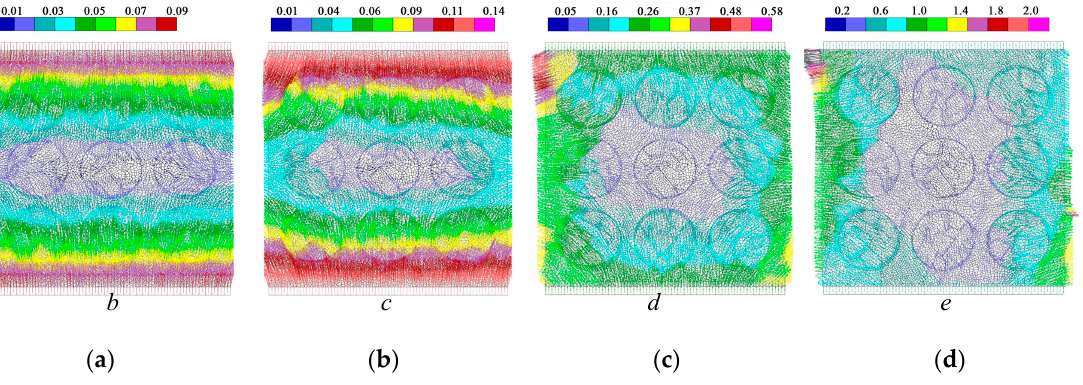
Figure 13. Displacement vectors of block corners from numerical simulation (unit: mm) ( a ) loading stage b ; ( b ) loading stage c ; ( c ) loading stage d ; ( d ) loading stage e .